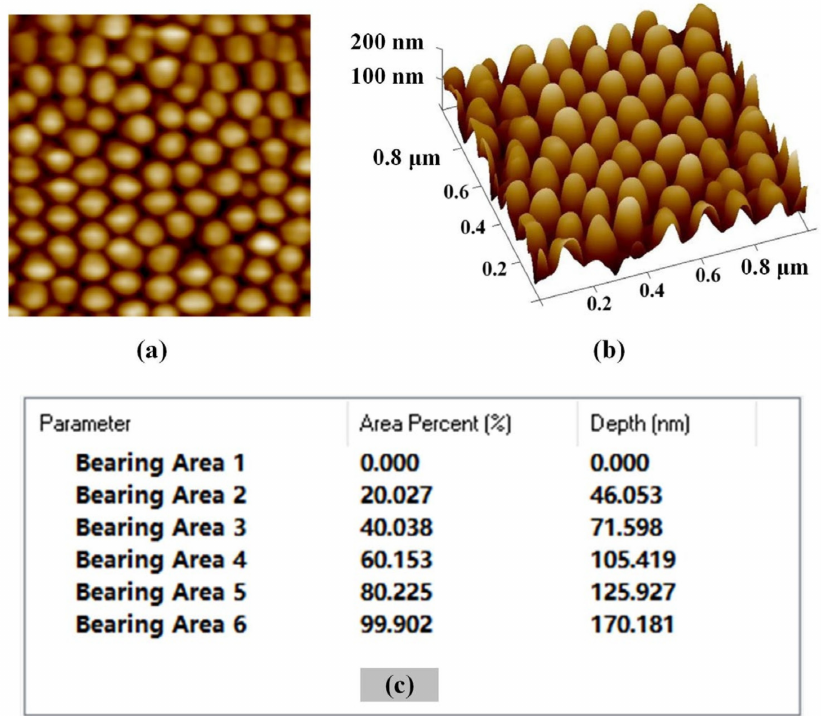
Figure 8. AFM characterization of the fabricated moth-eye nanostructure ( a ) two-dimensional topography ( b ) three-dimensional morphology ( c ) bearing